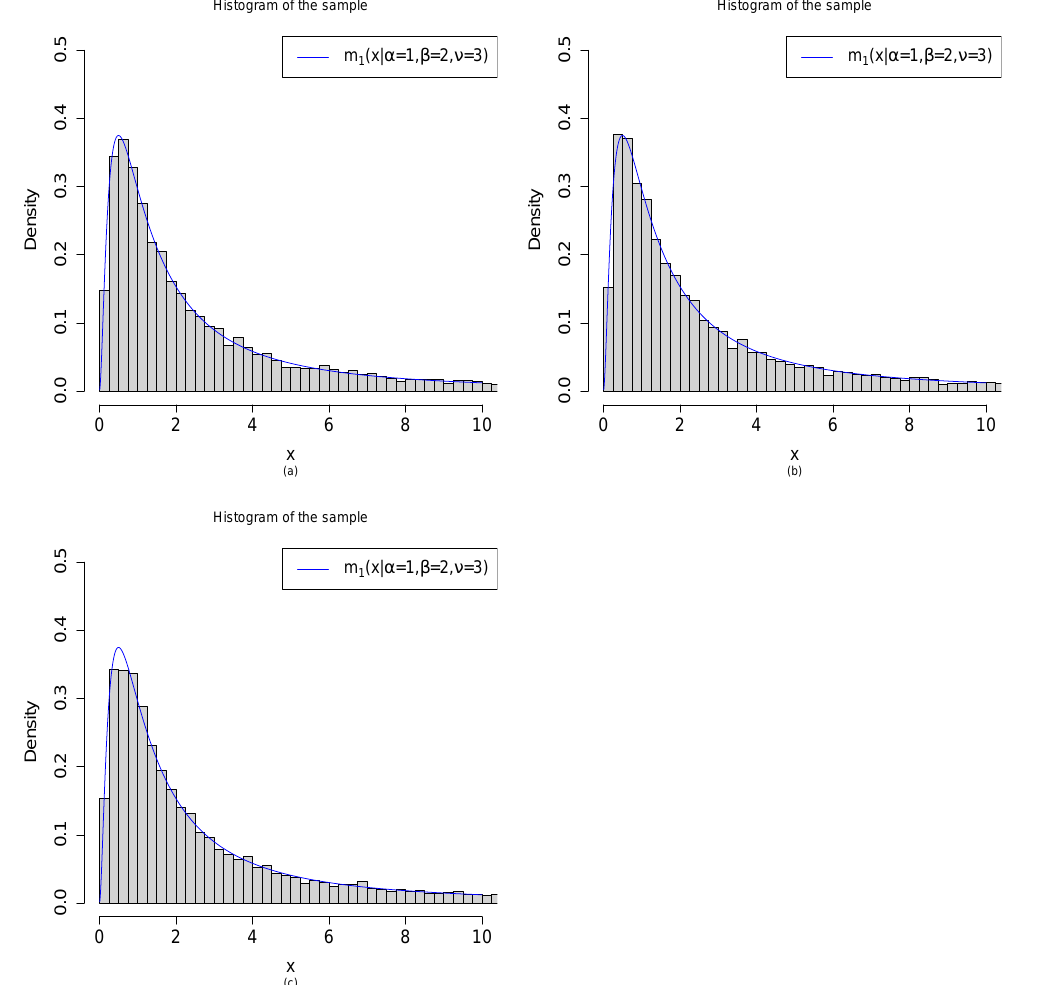
Figure 5. Random variable generations from m 1 ( x | α = 1, β = 2, ν = 3 ) by three methods with α = 1, β = 2, and ν = 3. ( a ) x i ( i = 1, . . . , n ) are iid from G − IG . ( b ) x i ( i = 1, . . . , n ) are iid from (cid:101) G − G